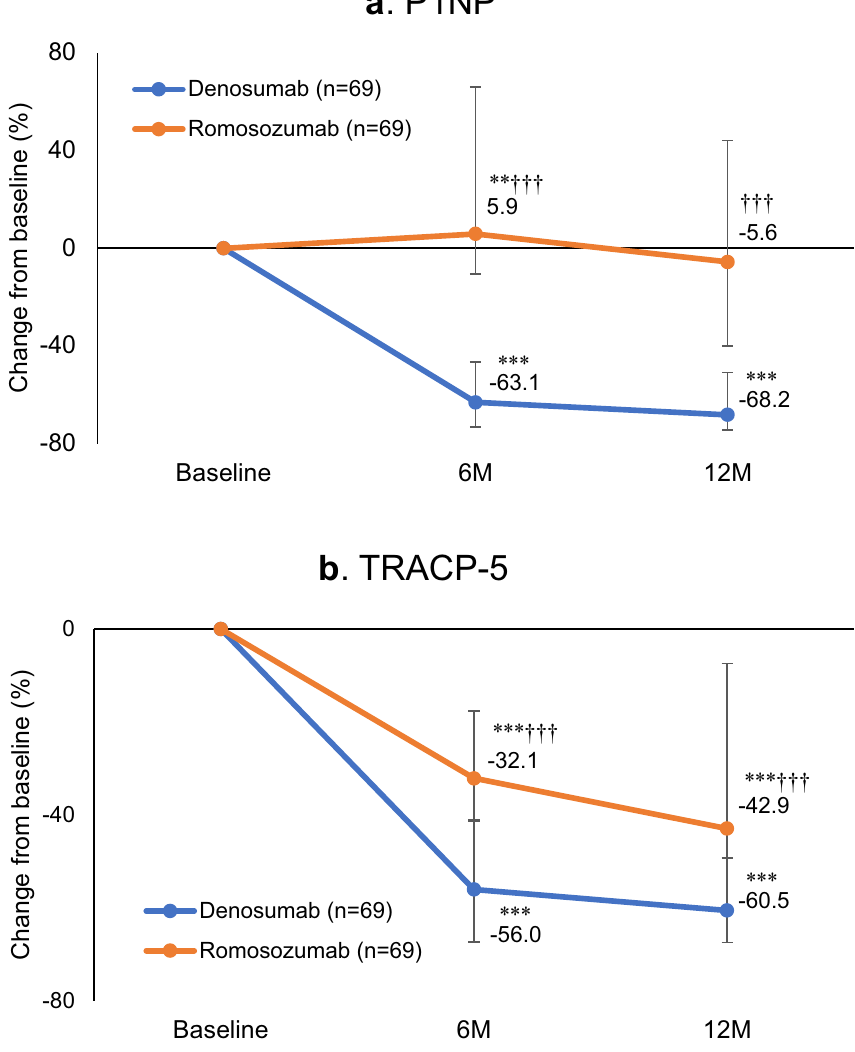
Figure 3. Median percentage changes from baseline to 6 and 12 months in ( a ) serum procollagen type 1 N-terminal propeptide (P1NP) level and ( b ) serum tartrate-resistant acid phosphatase isoform 5b (TRACP-5b). Bars indicate the median ± first or third quartile. **P < 0.01 and ***P < 0.001 versus baseline (Wilcoxon’s signed-rank test). ††† P < 0.001 versus denosumab (Wilcoxon’s rank-sum